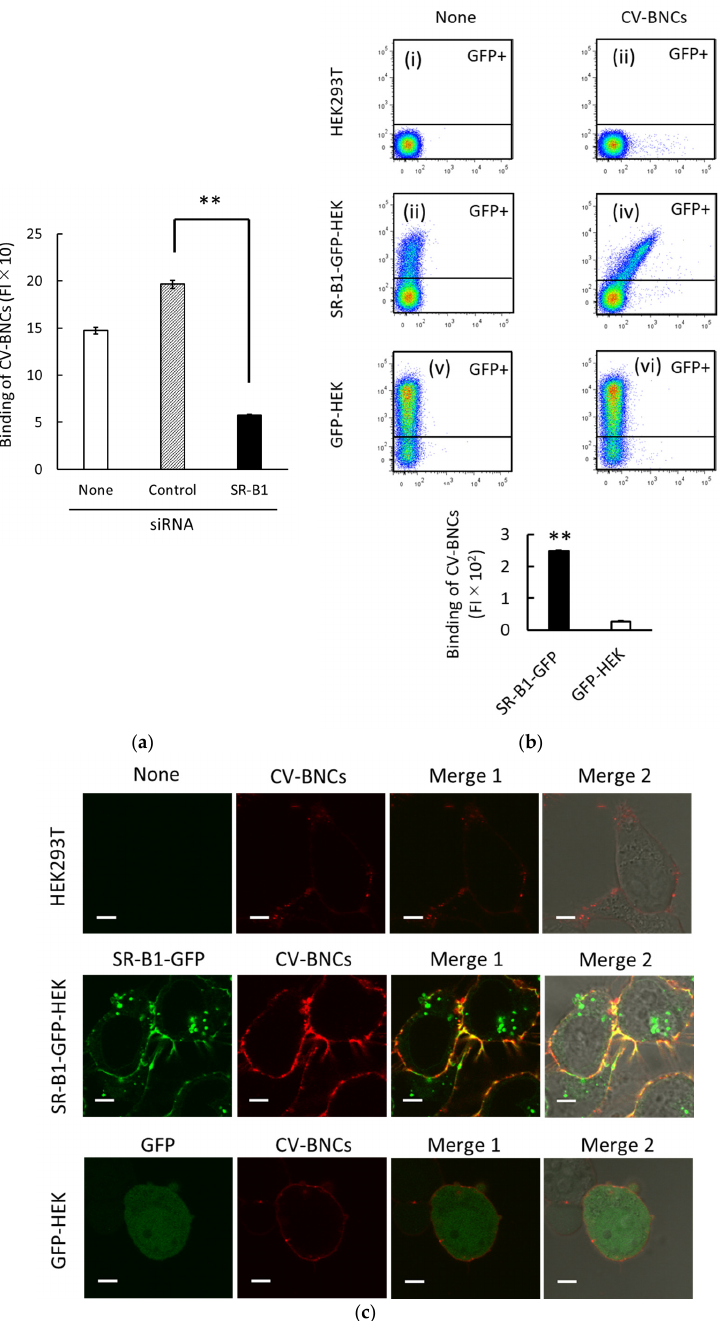
Figure 2. Binding of CV-labeled BNCs to SR-B1. ( a ) Suppression of CV-BNC binding to HEK293T cells by SR-B1 siRNA. After cells were treated with control or SR-B1 siRNA for 48 h, trypsinized cells were incubated with CV-BNCs (25 µ g/mL) on ice for 1 h. Binding of CV-BNCs to untreated (open bar), control siRNA-treated (hatched bar), SR-B1 siRNA (closed bar) was measured using flow cytometry. Statistical analysis was performed using Student’s t -test; ** indicates p < 0.01. ( b ) Binding of CV-BNCs to HEK293T, SR-B1-GFP-HEK, and GFP-HEK cells. In two-parameter dot plots (i–vi), vertical and horizontal axes indicate FI of GFP and CV-BNCs, respectively. In each dot plot, the upper gated area represents the GFP+ subset. The bar graph shows the BNC binding of the GFP+ subset in SR-B1-GFP-HEK (closed bar) and GFP-HEK cells (open bar). Statistical analysis was done in the same manner as (a). ( c ) Co-localization of SR-B1-GFP and CV-BNCs at the membrane of SR-B1-GFP-HEK cells. Binding of CV-BNCs in HEK293T (upper line), SR-B1-GFP-HEK (middle line), and GFP-HEK cells (bottom line) were observed under LSM. The fluorescence of GFP and CV is shown in red and green, respectively; Merge 1: GFP and CV fluorescence images are overlaid; Merge 2: GFP and CV fluorescence and bright filed images are overlaid. Bars indicate 5 µ